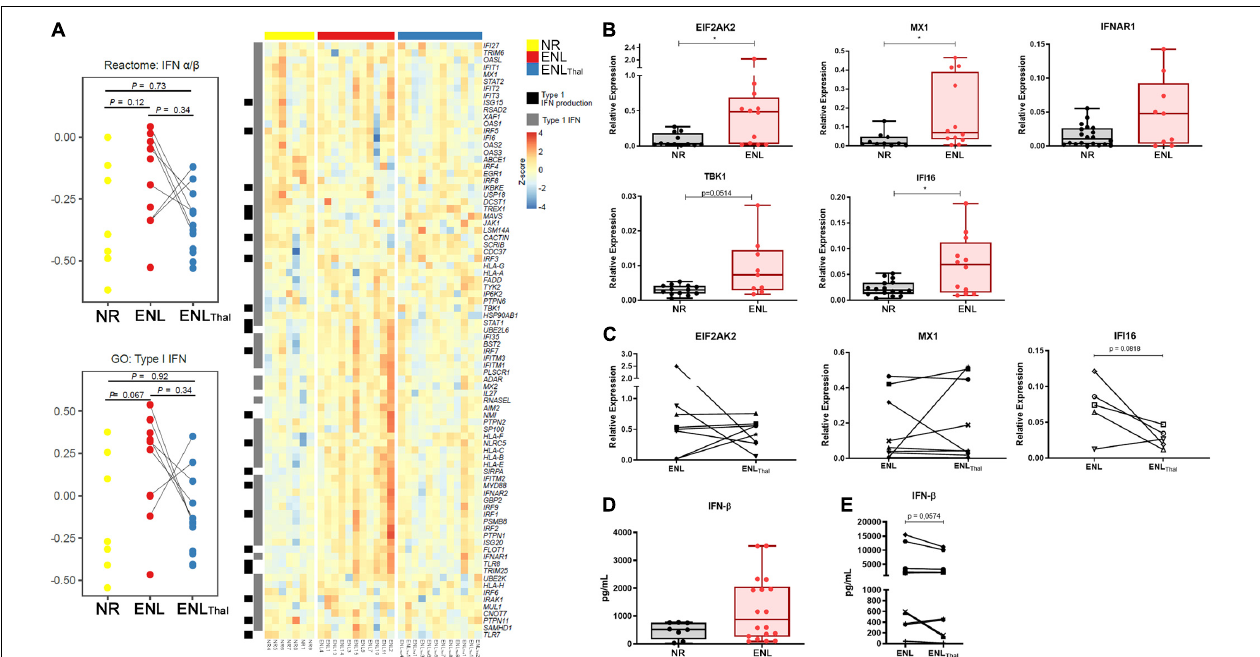
FIGURE 1 | Type I IFN pathway is positively regulated in the blood of ENL patients. Whole blood cells of non-reactional multibacillary leprosy patients (NR – n = 7, yellow ), ENL patients (ENL – n = 11, red ), and thalidomide-treated ENL patients (ENL Thal – n = 12, blue ) were properly collected and RNA was extracted using the PAXgene protocol. RNAseq was performed at NextSeq 550 platform and data analysis was performed using Salmon pipeline, followed by DESeq2 analysis to determine differentially- expressed genes. (A) On the left : Pathway score for the IFN-I pathway was determined using reactome IFN α / β and gene ontology type I IFN databases. On the right : Heatmap including type I IFN genes ( gray ) and Type I IFN production ( black ) from gene ontology database. (B,C) RNA from whole blood cells was extracted from NR, untreated ENL, or ENL patients on day 7 of thalidomide therapy (ENL Thal ) to validate the gene expression of ISG genes by RT-qPCR. RPL13 was used as an endogenous control. (B) Gene expression levels were determined in NR ( black ) and ENL patients ( red ) for EIF2AK2 (NR = 14, ENL = 14); MX1 (NR = 14, ENL = 15); IFNAR1 (NR = 20, ENL = 9); TBK1 (NR = 13, ENL = 9), and IFI16 (NR = 16, ENL = 12). * p < 0.05. (C) Follow-up gene expression analysis of EIF2AK2 ( n = 8), MX1 ( n = 9), and IFI16 ( n = 5) in ENL patients before (ENL) and at day 7 of thalidomide treatment (ENL Thal ). (D,E) IFN- β levels in serum samples of NR and ENL leprosy patients. (D) Serum concentrations of IFN- β were evaluated by enzyme-linked immunosorbent assay (ELISA) in NR ( n = 8, black ) and ENL patients ( n = 18, red ). (E) Serum concentrations of IFN- β in a longitudinal follow-up measurement of leprosy patients diagnosed with ENL and after 7 days of thalidomide treatment ( n = 13). Box plots show median, interquartile range, sample minimum and maximum. Each dot represents a